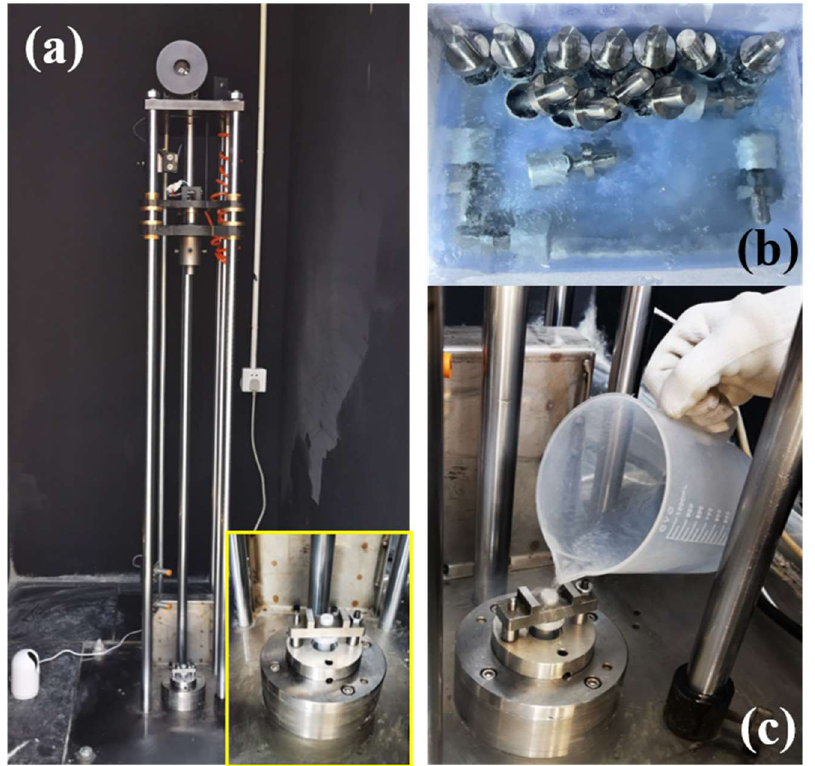
Figure 2. ( a ) 98J LOT machine with high-definition camera, ( b ) samples, specimen cup and striker pin immersed in liquid oxygen and ( c ) liquid oxygen poured into the specimen cup before impact.